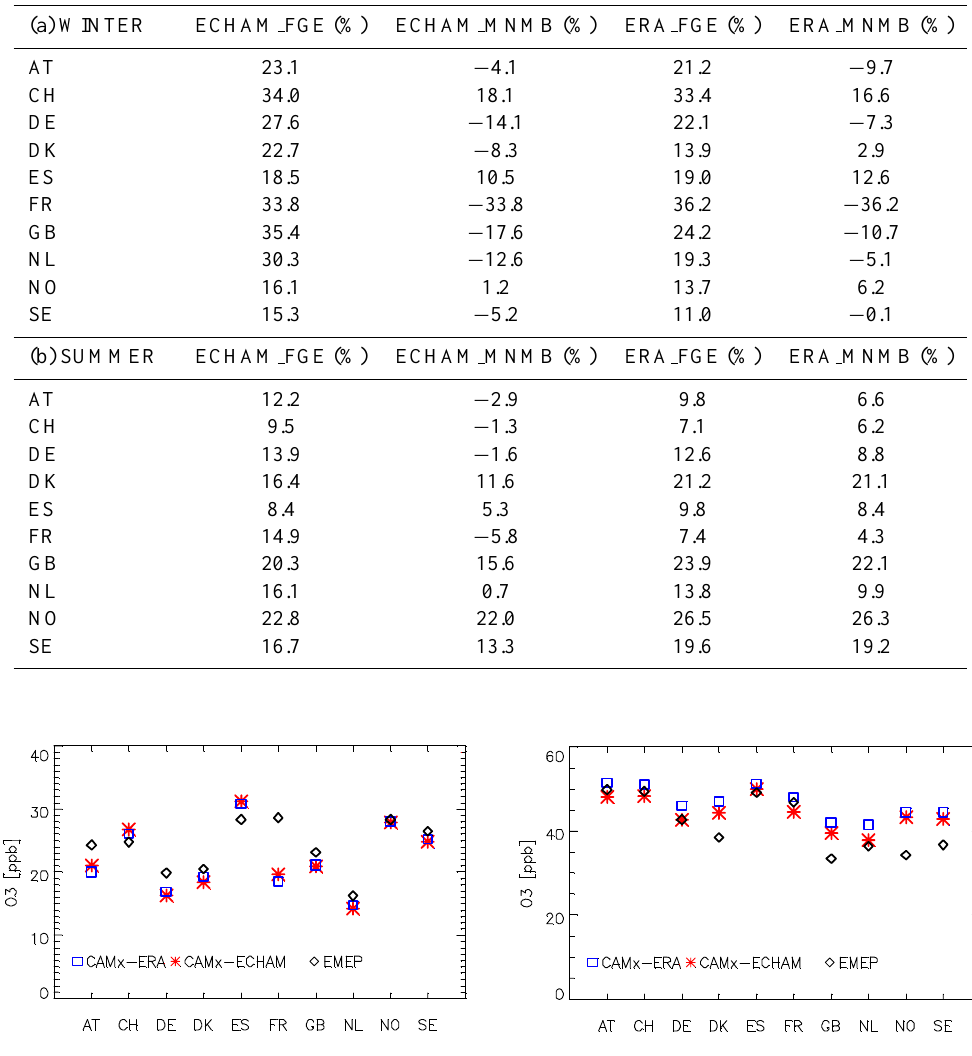
Table 1. Fractional gross error (FGE) and Modified Normalized Mean Bias (MNMB) for average decadal (1991–2000) daytime surface ozone concentrations for the ECHAM and ERA simulations (a) winter (DJF) (b) summer (JJA). For the country codes see text.